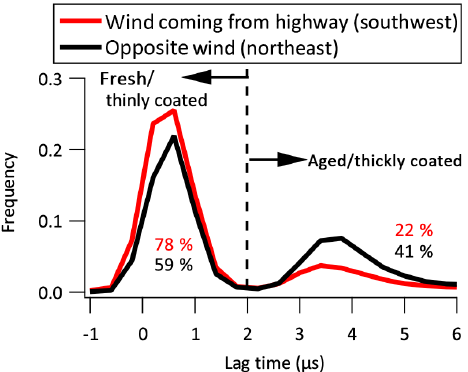
Figure 4. Campaign-average frequency distributions (histograms) of SP2 lag time ( (cid:49)τ ) for refractory-BC-containing particles mea- sured during periods with winds from the highway (red) or from the opposite direction (black). Measurements were collected at a dis- tance of 10m from the highway in